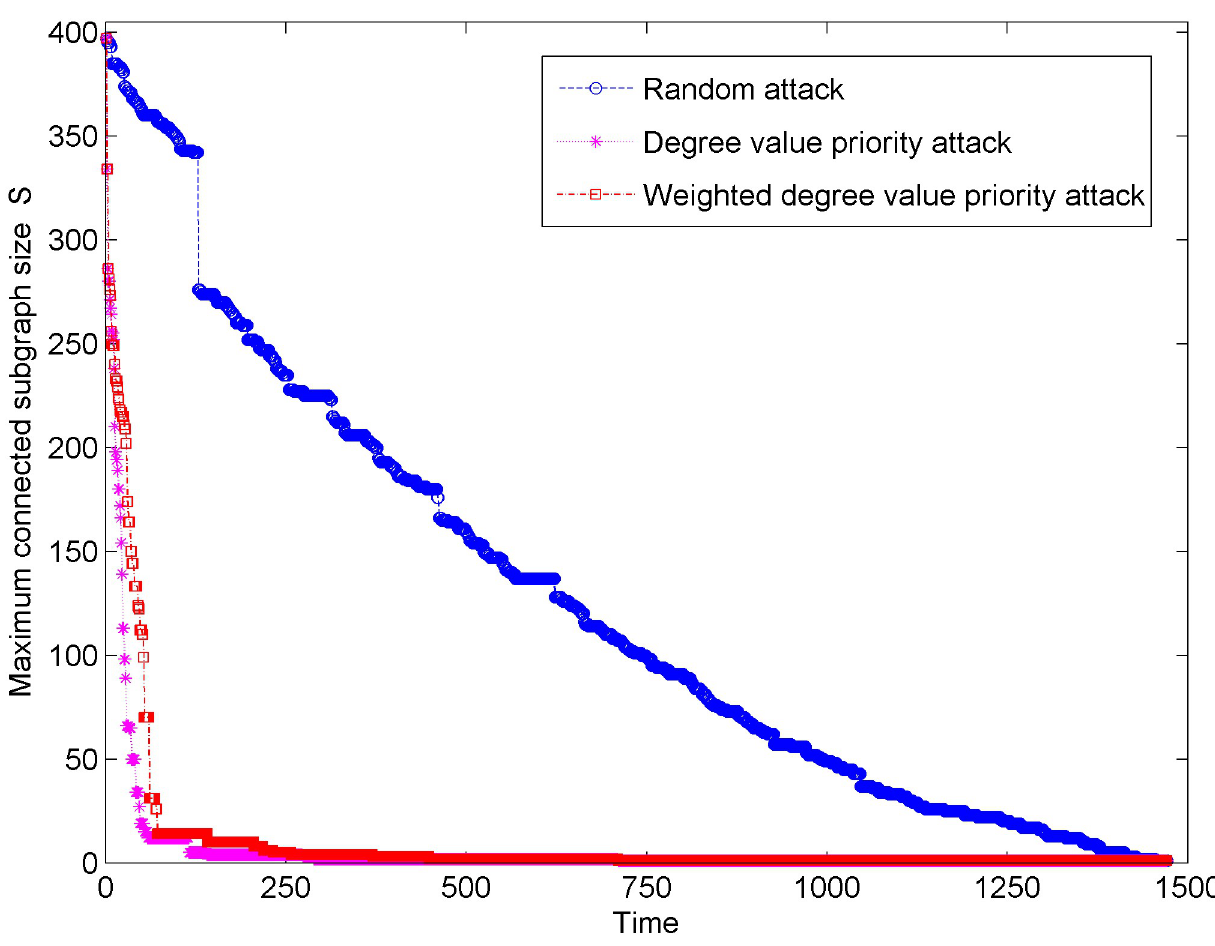
Fig 2. Change in maximum connected subgraph size under three types of